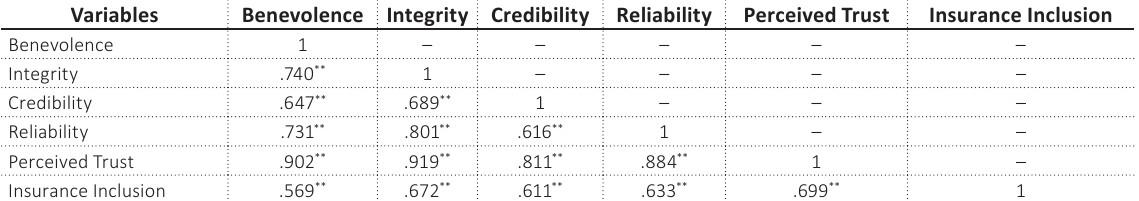
Table 4. Correlation analysis